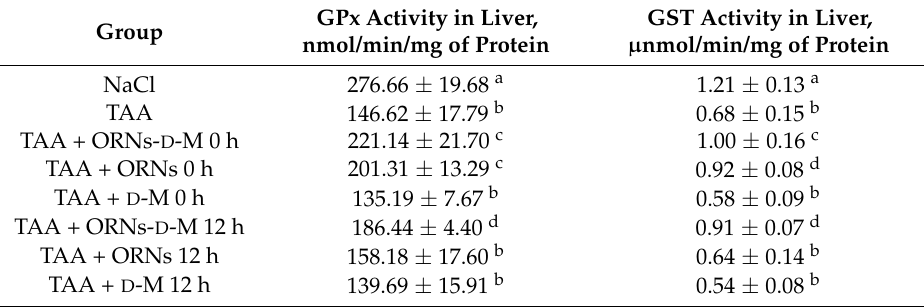
Table 1. Effects of ORNs- D -M, ORNs and D -M on the activities glutathione peroxidase (GPx) and glutathione S-transferase (GST) in TAA-induced liver damage mice. GPx Activity in Liver, GST Activity in Liver, Group µ nmol/min/mg of Protein nmol/min/mg of Protein NaCl 276.66 ± 19.68 a 1.21 ± 0.13 a TAA 146.62 ± 17.79 b 0.68 ± 0.15 b TAA + ORNs- D -M 0 h 221.14 ± 21.70 c 1.00 ± 0.16 c TAA + ORNs 0 h 201.31 ± 13.29 c 0.92 ± 0.08 d TAA + D -M 0 h 135.19 ± 7.67 b 0.58 ± 0.09 b 186.44 ± 4.40 d 0.91 ± 0.07 d 158.18 ± 17.60 b 139.69 ± 15.91 b 0.54 ± 0.08 b Data are presented as the mean ± SD, n = 6 for each group. Values marked with different letters (a, b, c, d) are statistically different, p < 0.05 (Student’s t -test). Abbreviations: NaCl—control mice receiving a single injection of NaCl; TAA—mice receiving a single injection of TAA; ORNs- D -M 0 h—mice receiving a TAA and ORNs- D -M immediately after TAA application (i.e., 0 h) and every next 12 h for 48 h; ORNs 0 h—mice receiving a TAA and ORNs immediately after TAA application (i.e., 0 h) and every next 12 h for 48 h; D -M 0 h—mice receiving a TAA and then D -M immediately after TAA application (i.e., 0 h) and every next 12 h for 48 h; ORNs- D -M 12 h—mice receiving a TAA and ORNs- D -M after 12 h after TAA application (i.e., 12 h) and every next 12 h for 48 h; ORNs 12 h—mice receiving a TAA and ORNs after 12 h after TAA application (i.e., 12 h) and every next 12 h for 48 h; D